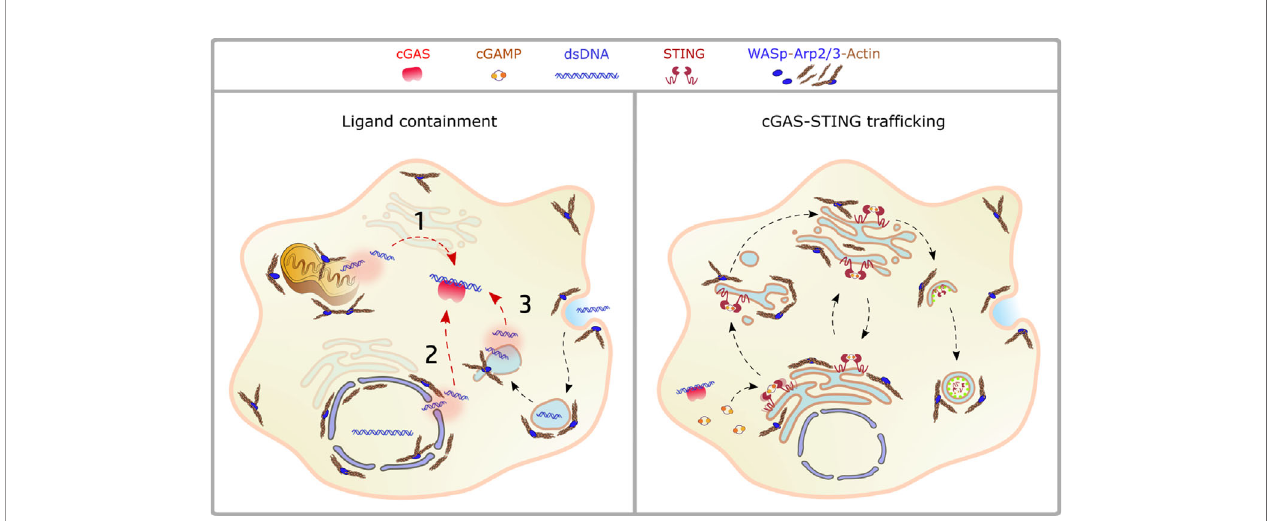
FIGURE 2 | Crosstalk between actin dynamics and cGAS-STING pathway. Left panel: ligand availability into the cytosol may derive from mitochondrial dysfunction (1), nuclear damage (2), endolysosomal leakage (3). The actin cytoskeleton controls both morphology and stability of these compartments, as discussed in the text. Right panel: the scheme depicts STING traf fi cking steps highlighting the processes controlled by actin dynamics. NPFs of the WASp family regulate vesicles budding from the ER, cargo loading onto COPII vesicles, Golgi stability and post-Golgi traf fi cking steps, including incorporation into autophagosomes and